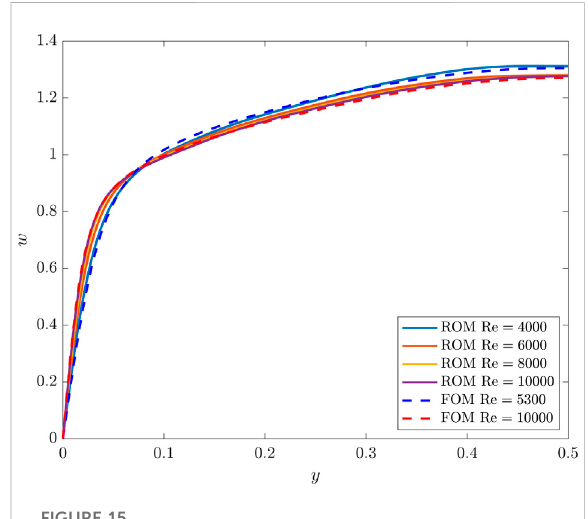
FIGURE 15 Time- and space-averaged axial velocity pro fi les for ABM- ROM